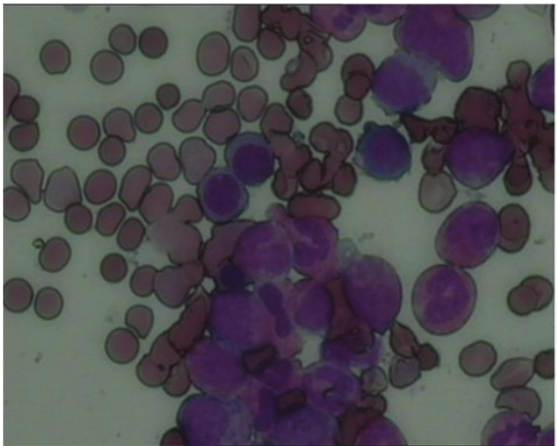
Figure 1: Bone marrow smear shows typical chronic Figure 2: Typical chronic myeloid leukemia